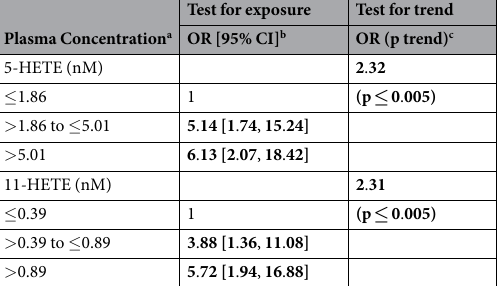
Table 4. Non-esterified plasma oxylipids concentrations of 5- and 11-HETE, as tertiles, are positively associated with polyp presence. a Plasma non-esterified oxylipids were separated into tertiles. b Test for exposure was conducted to determine if increases in oxylipid tertiles, compared to the lowest tertile, were associated with having polyps. Odds ratio (OR) [95% Confidence Interval (CI)] are displayed. c Test for trend was conducted to determine if increases in oxylipid tertiles were associated with presence of polyps compared to no polyps. Odds ratio (p-value) are displayed. b,c Polytomous logistic regression was used to regress polyp presence on oxylipid tertiles. All data is referenced against the no polyps’ category. Both test for trend and test for exposure were adjusted for body mass index, age, and smoking. P-values bolded if p ≤